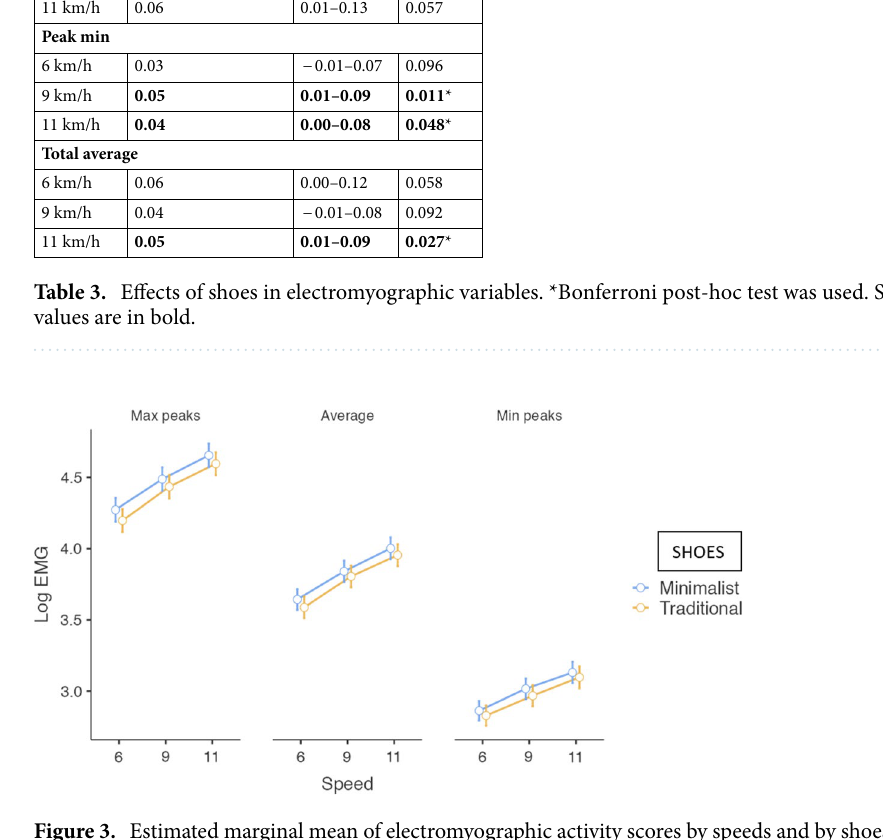
Figure 3. Estimated marginal mean of electromyographic activity scores by speeds and by shoes in PFM. Error bars represent the standard error of the